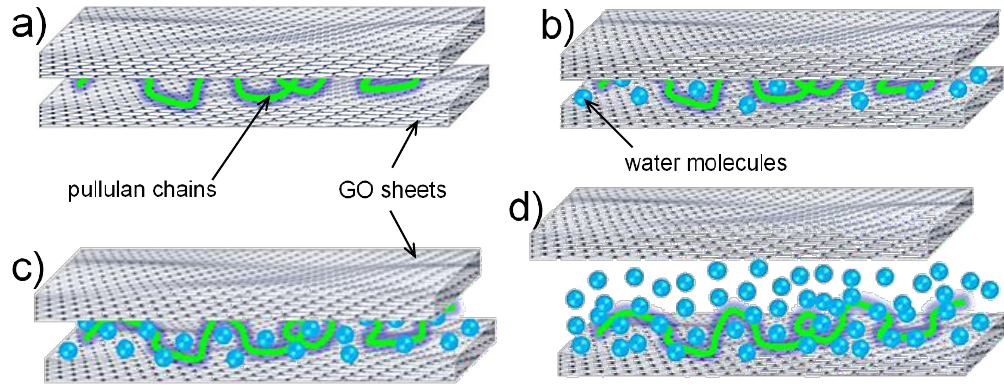
Figure 3. Schematic representation of the pullulan/GO nanocomposite system ( a ) in dry conditions and upon effect of relative humidity set at ( b ) 30%; ( c ) 60%; and ( d ) 90%.